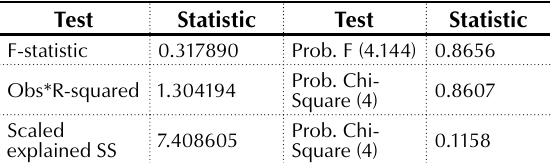
Table 1. Heteroskedasticity test: the White test results